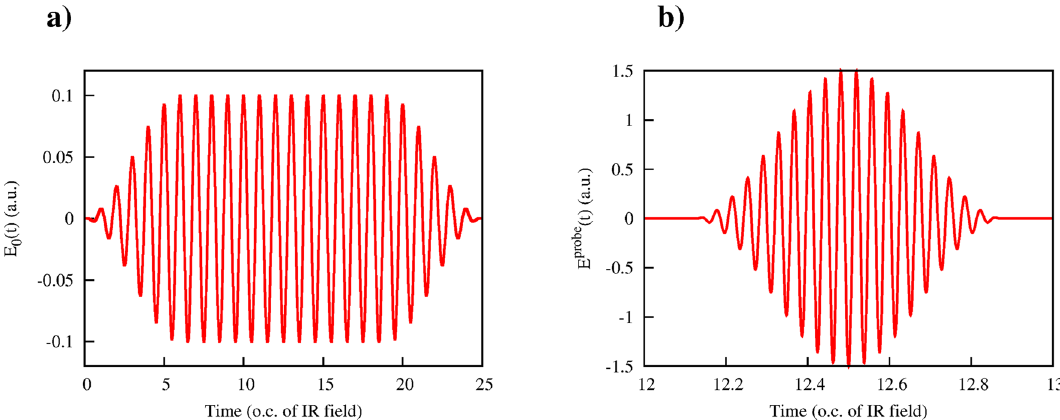
component of the XUV field ( b ) used in the − 0.1 a.u., ω 0.0577 a.u. XUV field parameters: E probe = =